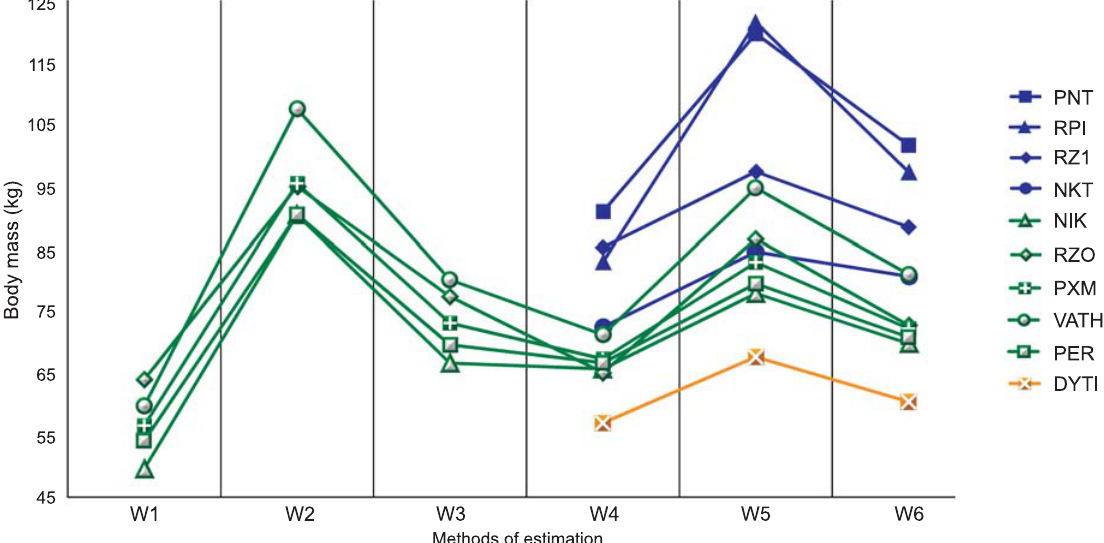
Fig. 10. Body mass of Hipparion macedonicum from the various Greek localities calculated by various methods and its change in relation to the time. The body mass is estimated using the metapodials (Eisenmann and Sondaar 1998); W1. ln(body mass) = -5,768+3.011 x (lnMc10); W2. ln(body mass) = -3.151+2.665 x (lnMc13); W3. ln(body mass) = -4.525+1.434 x (ln(Mc10 x Mc13)); W4. ln(body mass) = -4.362+2.634 x (lnMt10); W5. ln(body mass) = -4.552+3.100 x (lnMt13); W6. ln(body mass) = -4.585+1.443 x (ln(Mt10 x Mt13)).